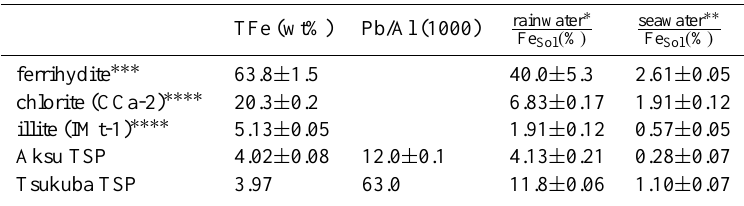
Table 1. Solubilities of Fe in simulated rainwater and